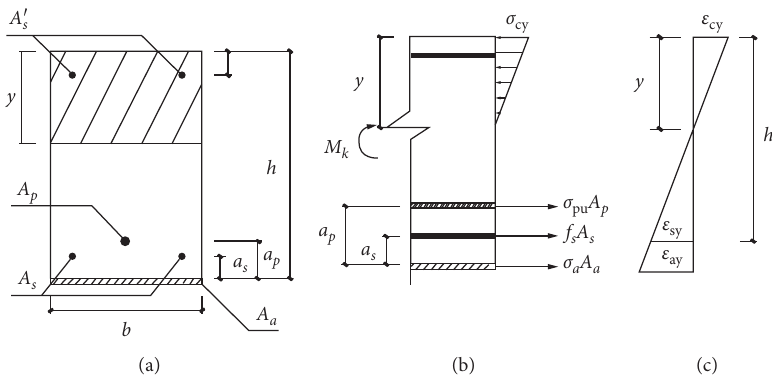
Figure 11: The distribution of stress and strain of the section when the non-prestressed reinforcement was